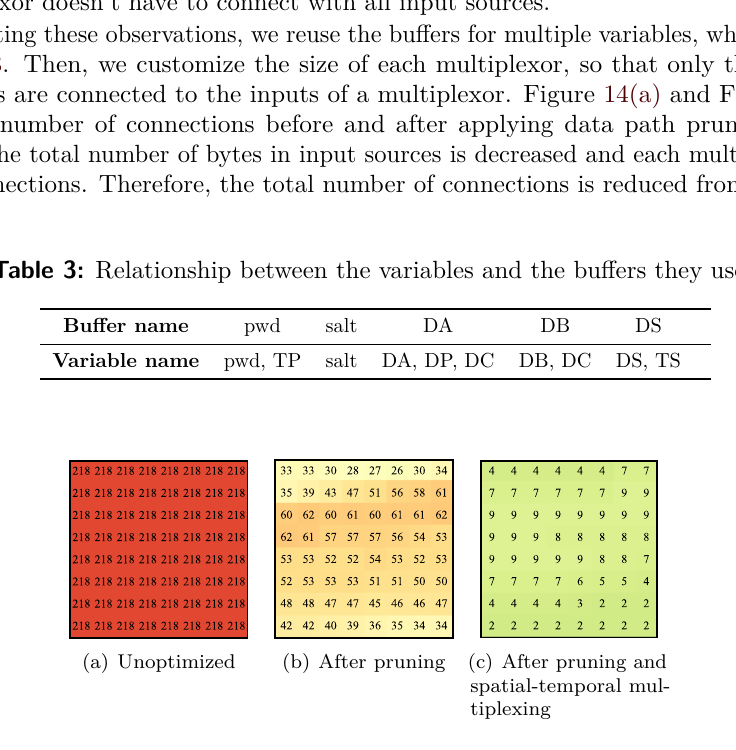
Figure 14: Data path hotmap. Each grid represents a byte in the block. The number marked on the grid represents the number of connections for the corresponding